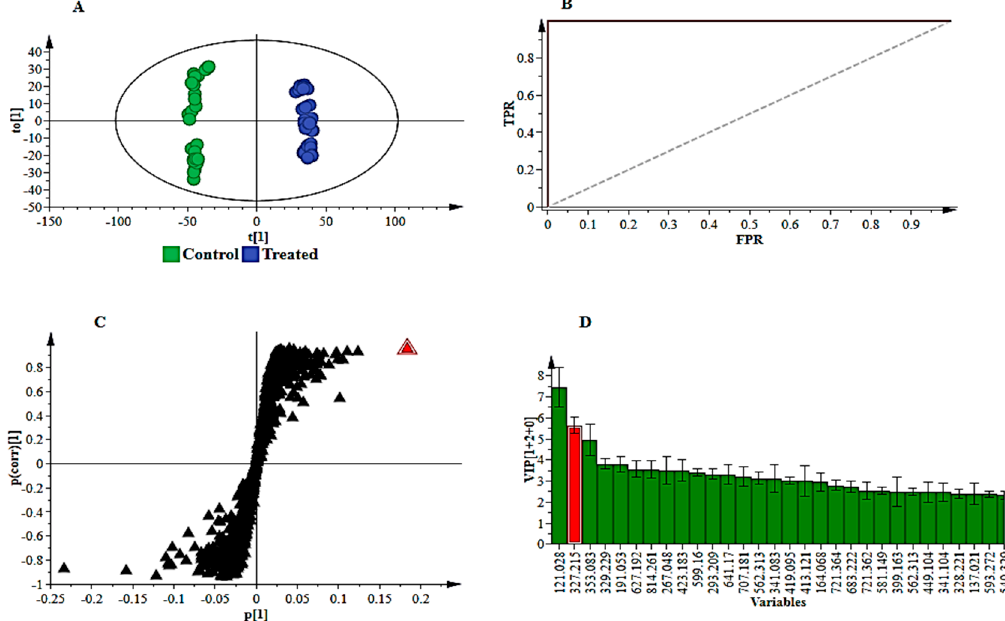
Figure 3. Supervised multivariate analyses of the ESI negative UHPLC-MS data for NS 5511 (BT) cultivar extracts. ( A ): The OPLS-DA score plot shows grouping of control vs. infected for all samples. This model comprises 1 predictive component and 2 orthogonal components (R 2 X= 67.2%, R 2 Y= 99.3% and Q 2 = 98.7%). ( B ): A representative receiver operator characteristic (ROC) plot summarising the performance of OPLS-DA (a binary classification method). ( C ): The OPLS-DA loading S-plot displays the discriminating features (ions) that explain the clustering (sample grouping) observed in the OPLS-DA scores plot, with the features in the top right quadrant positively correlated to the treatment and those in the bottom left quadrant negatively correlated to the treatment. The loading S-plot comprises 1 predictive component explaining 47.1% of the total variation and 2 orthogonal components explaining 20.1% of the total variation. ( D ): A VIP plot summarising the importance of some of the variables in the projection of the model. A VIP value >1 is significant/important in the projection and higher score values indicate an increase in significance of the variables.